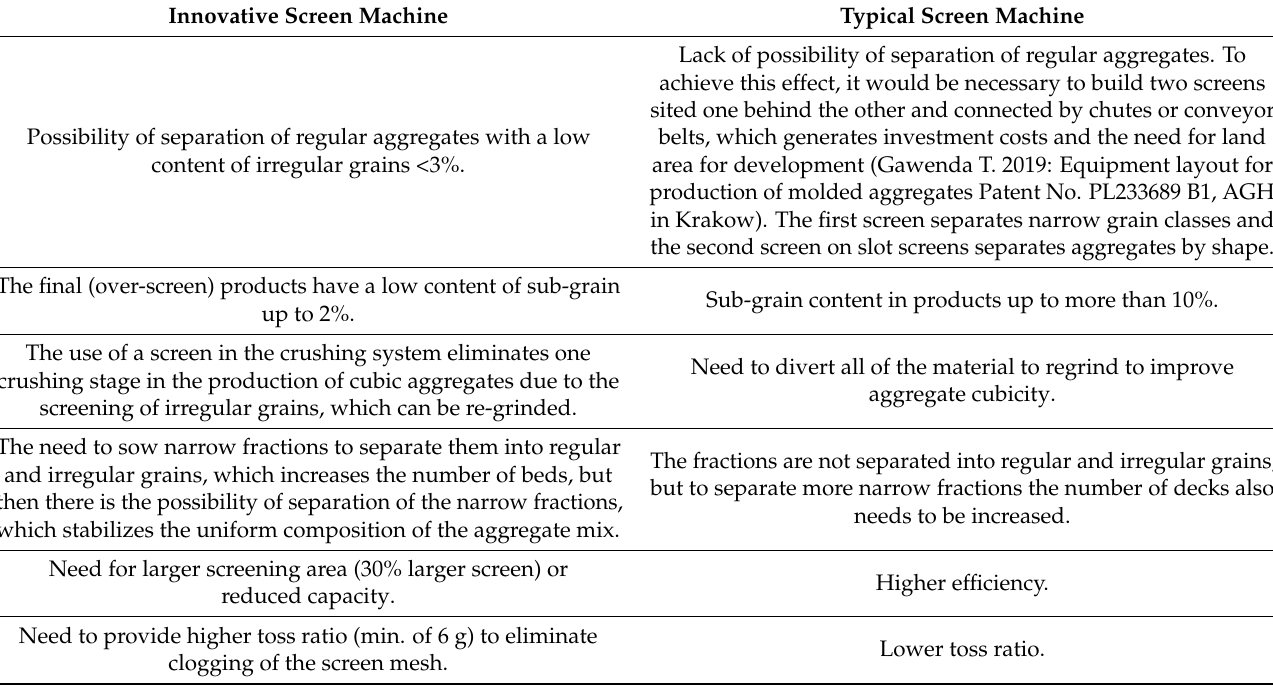
Table 1. Advantages and disadvantages of the innovative and ordinary screens in the technological system for the production of regular aggregates.